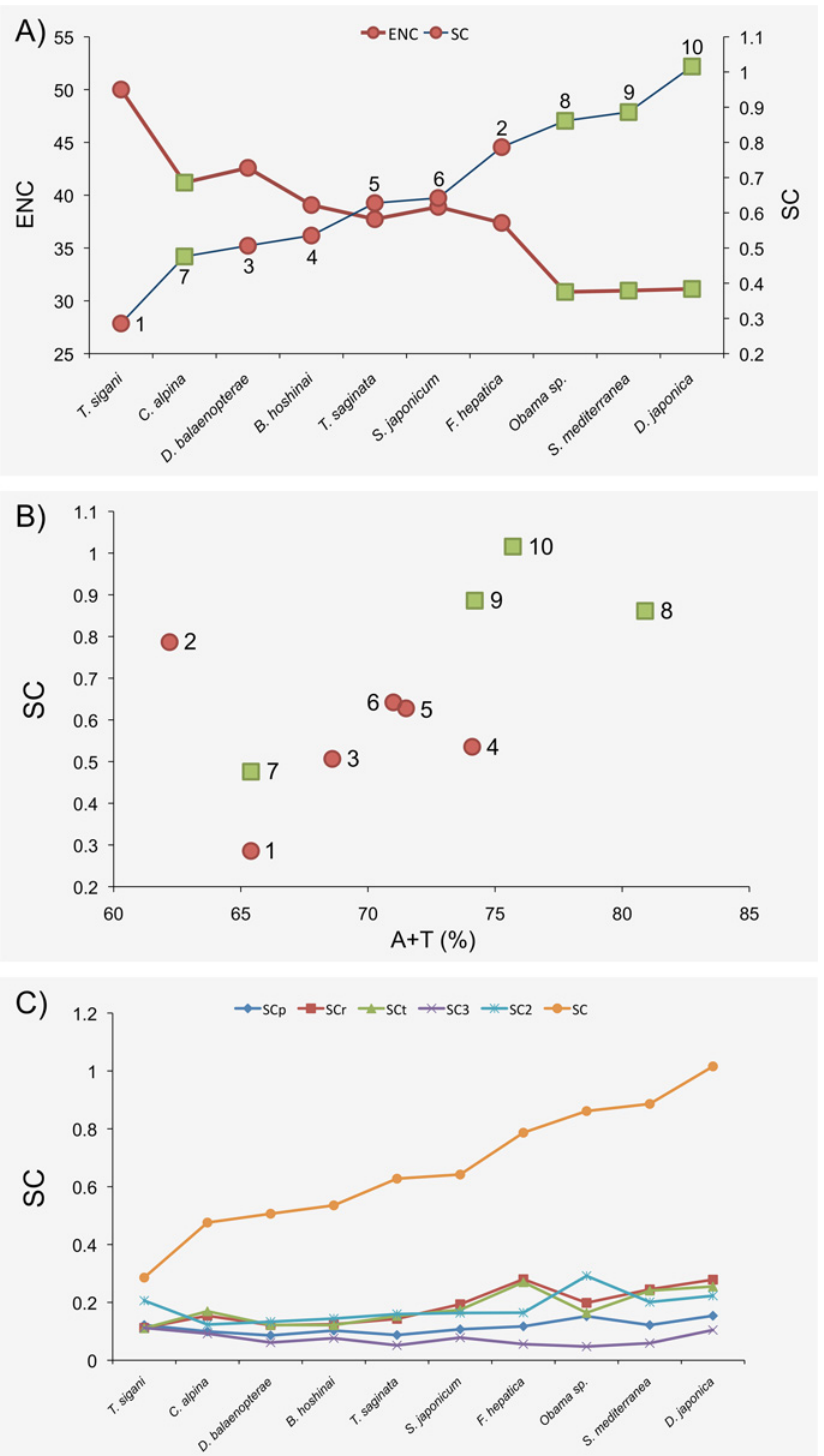
Fig 5. Relationship between different codon bias measures. A) Relationship between ENC and SC values. B) Relationship between SC and A+T% values. C) SC values across species (see Material and Methods text for acronym description). Green squares and red circles indicate free-living and parasitic Platyhelminthes, respectively. The surveyed species are shown in numbers: 1, T . sigani ; 2, F . hepatica ; 3, D .